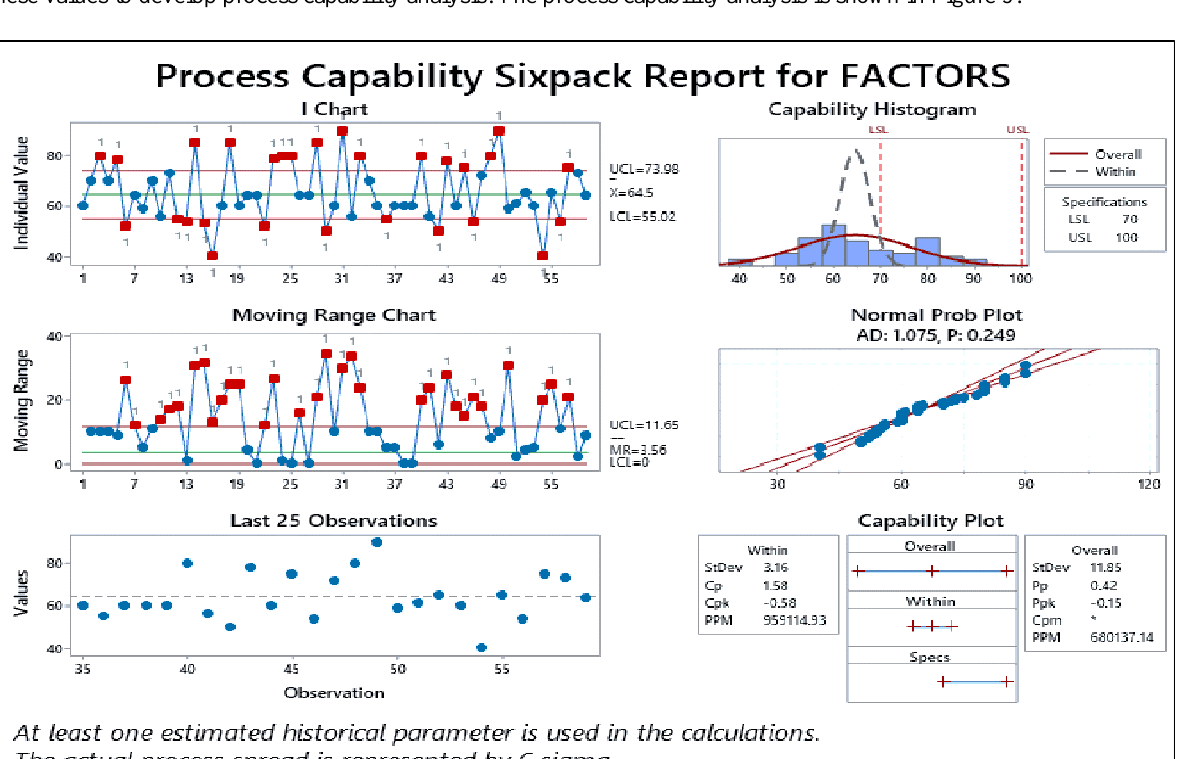
Figure 3. Process capability Sixpack